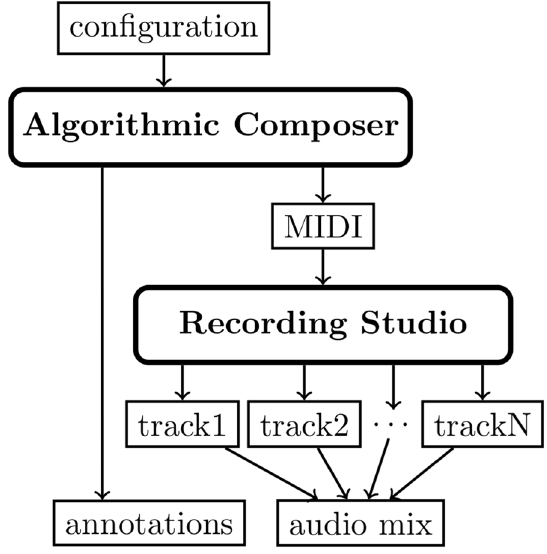
Fig. 1 Modules of the fully automated generation process. The AAM dataset contains all configurations, symbolic MIDI files, single instrument audio tracks, mixed tracks and